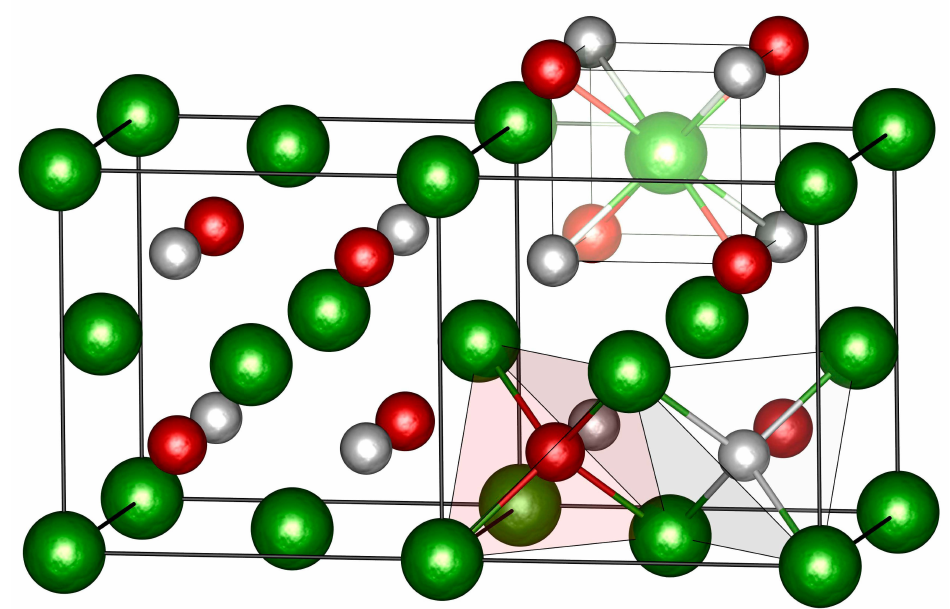
Figure 4. The crystal structure and coordination polyhedra of DyHO and ErHO; two unit cells are shown. Color code: Dy/Er, green; H, white; O, red.